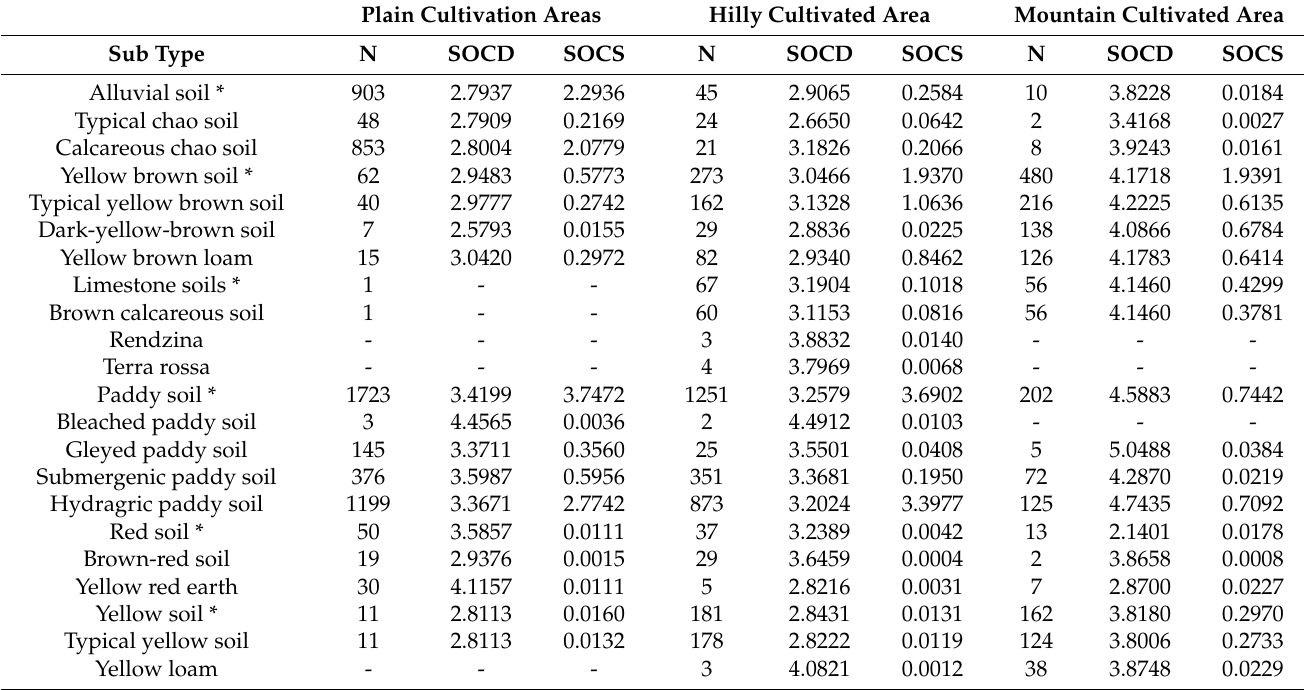
Figure 4. SOCD according to soil type in different terrains. 1: plain cultivation areas; 2: hilly cultivated areas; 3: mountainous cultivated areas. Table 3. Summary statistics of SOCD (kg/m 2 ) and SOCS (Tg) according to soil subclass and topog- raphy.